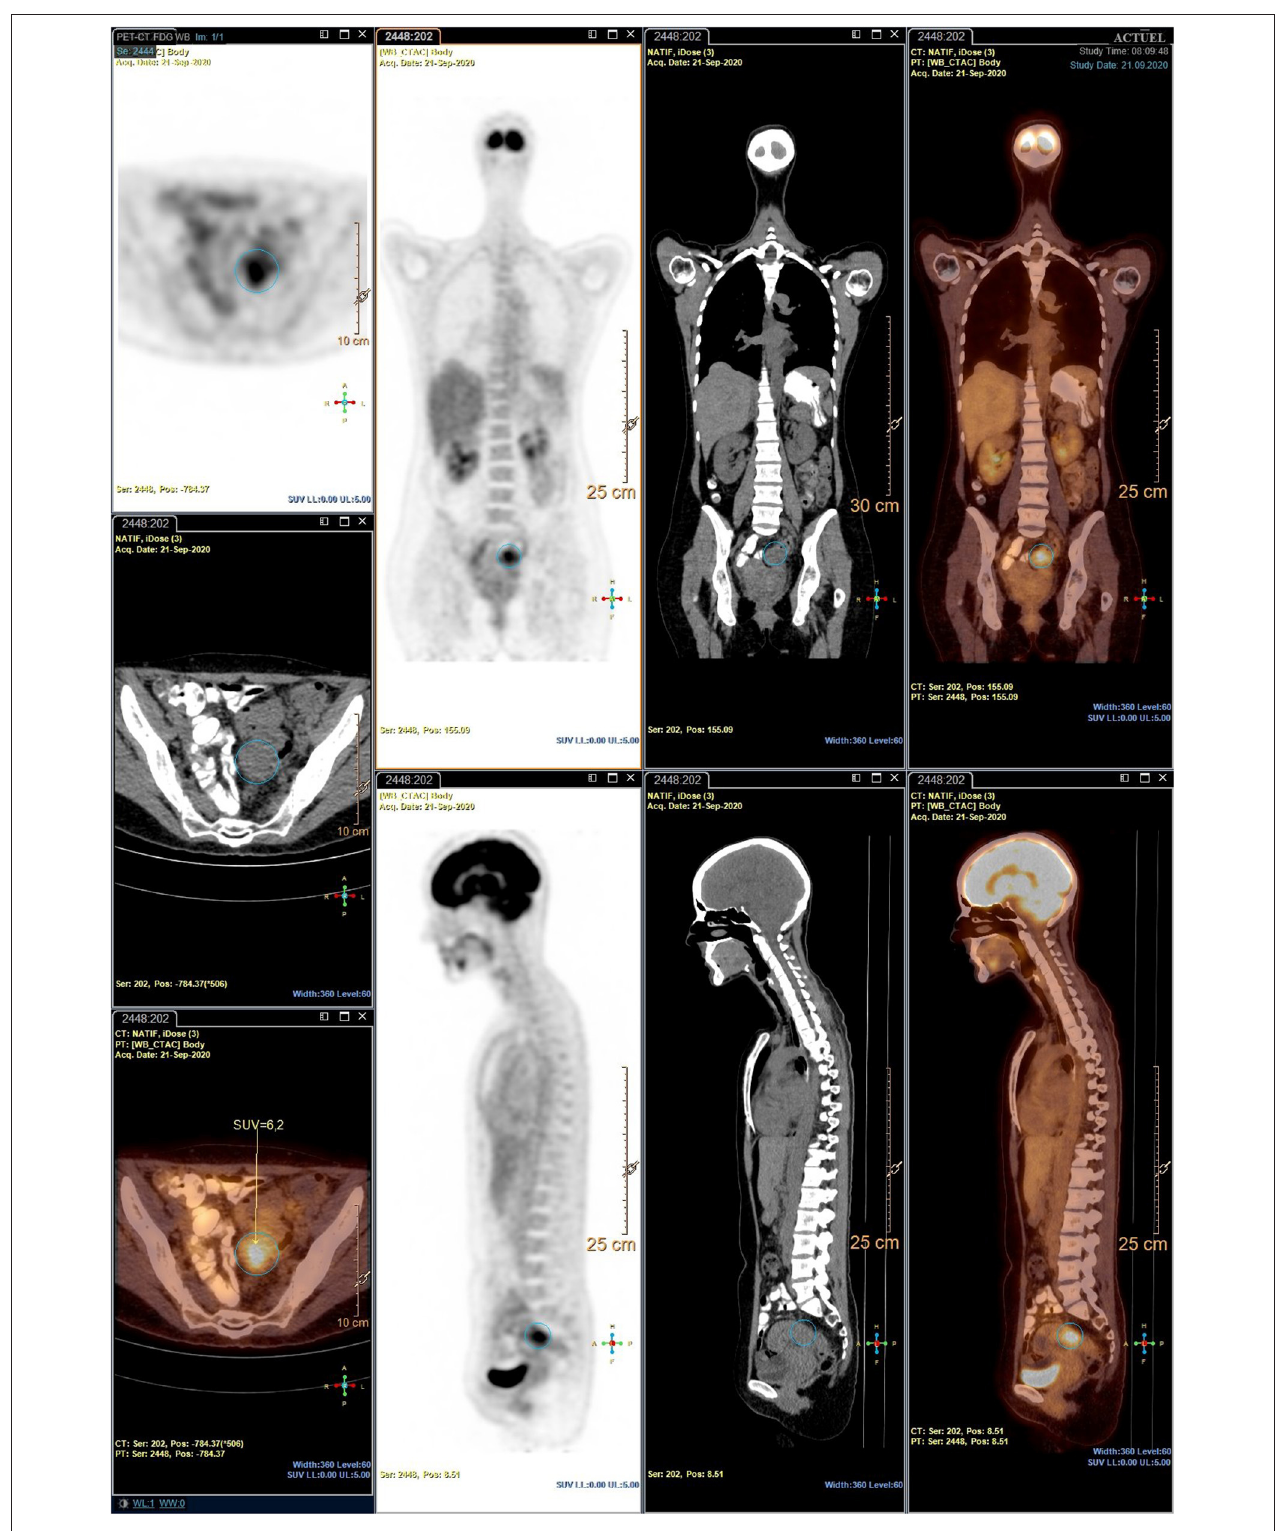
FIGURE 1 | 18F-FDG PET-CT, pre-treatment with Bevacizumab: intense recto-sigmoid hypercaptation (circled in blue) without further hypermetabolic lesions.